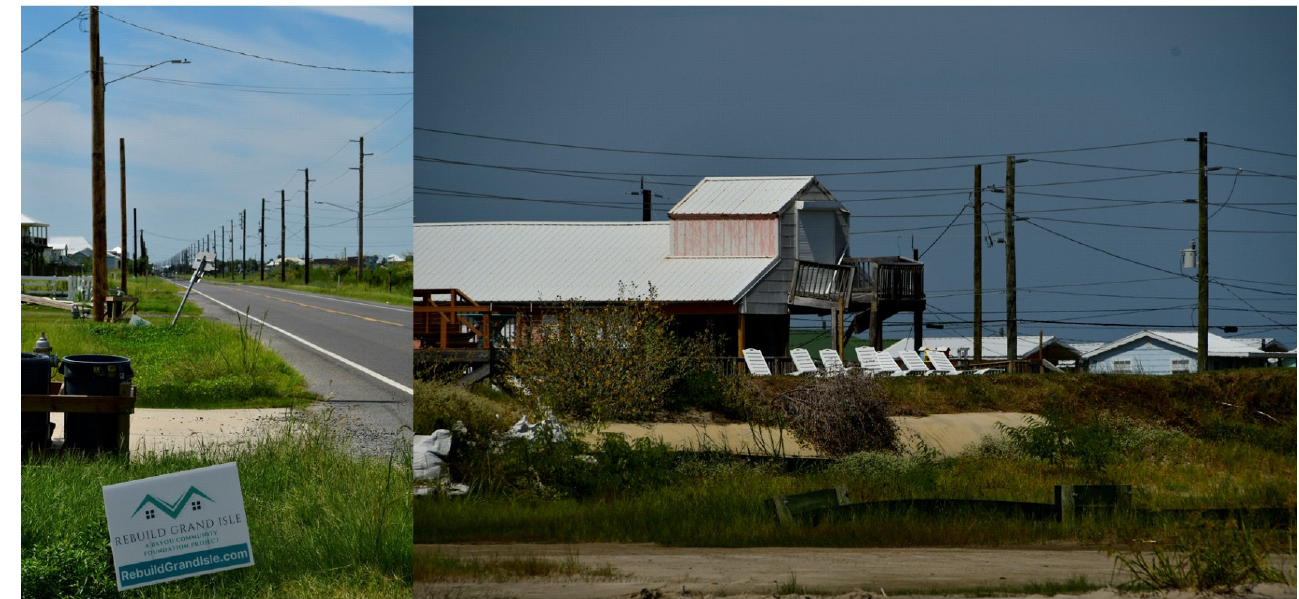
Figure 6. In September, almost exactly one year after Hurricane Ida hit Grand Isle, most of the debris has been removed and many of the camps and houses have been rebuilt or deconstructed, although there are still buildings in need of repairs and reconstruction (as visible in the picture on the right). The deck chairs on the levee, which is still damaged in some places, illustrate the attempt to return to normalcy and are in stark contrast to the building in the background, which is still in need of reconstruction. Signs of a campaign to rebuild Grand Isle in front of many buildings visualizes the community spirit of the inhabitants and their optimism and attachment to the island (left; photographs: Koegst September 2022).